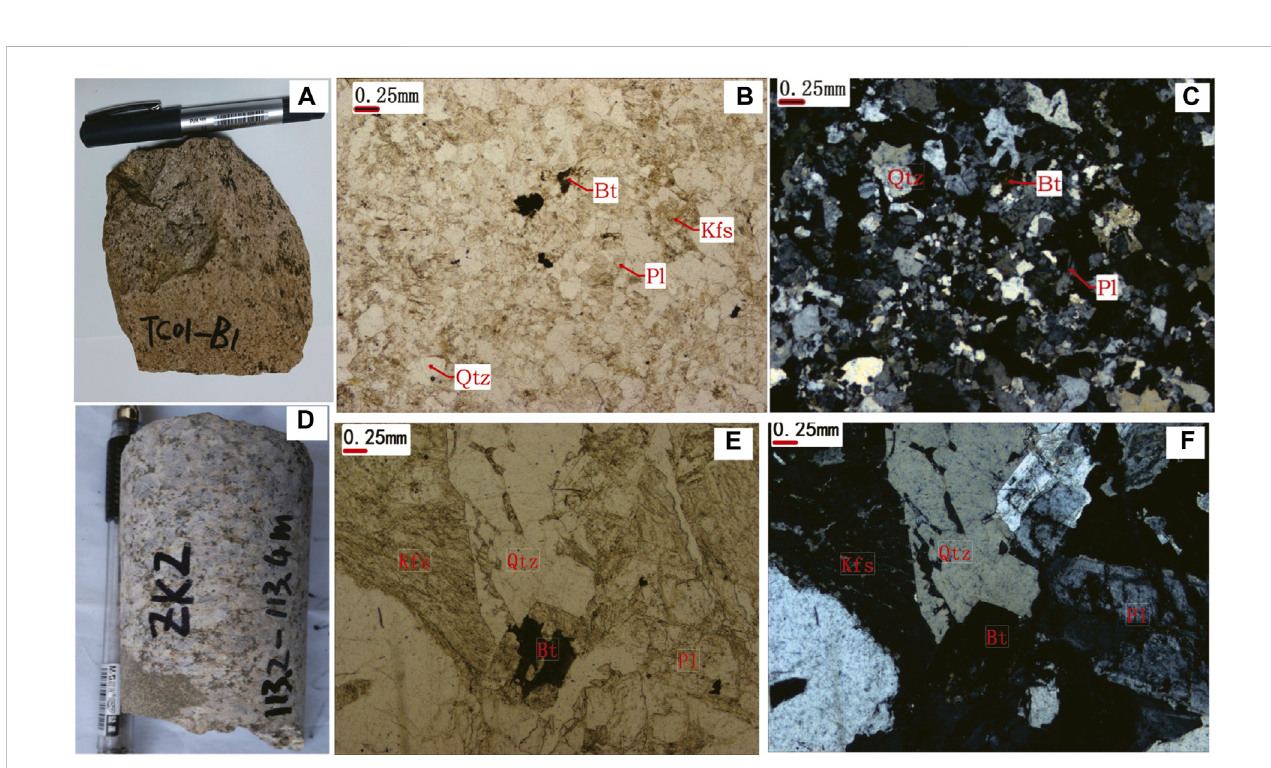
FIGURE 7 Representative hand sample and photomicrographs for the granitic intrusions in the Xinchenggou area, Dongning County. (A) syenogranite; (B) syenograniteinplane-polarizedlight; (C) syenograniteincross-polarizedlight; (D) monzogranite; (E) monzograniteinplane-polarizedlight; (F) monzogranite in cross-polarized light. Abbreviations: Kfs, K-feldspar; Bt, Biotite; Pl, Plagioclase; Qtz,